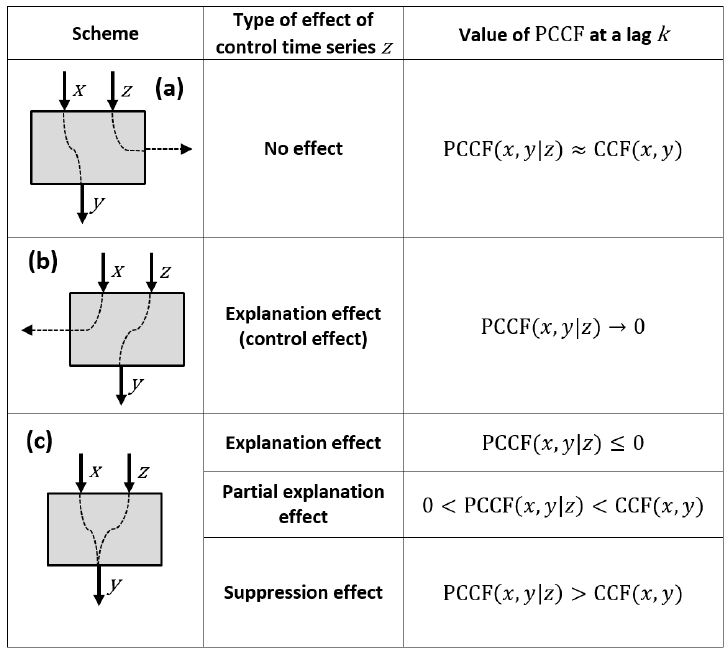
Figure 2. Schematic presentation of effects for a hydrological system with two input time series of uncorrelated rainfall, x and z , and an output time series of discharge y : ( a ) there is no relationship between series z and y , ( b ) there is no relationship between series x and y , ( c ) series x and z are antecedent cause of output series y .